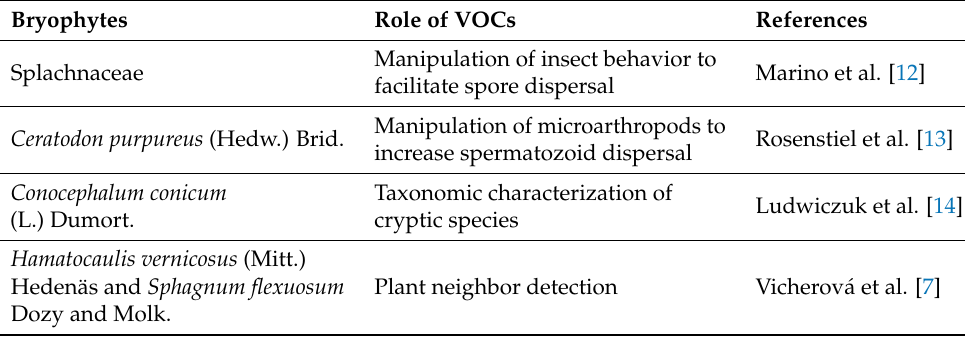
Table 5. A summary of the role of volatile organic compounds (VOCs) in bryophytes.